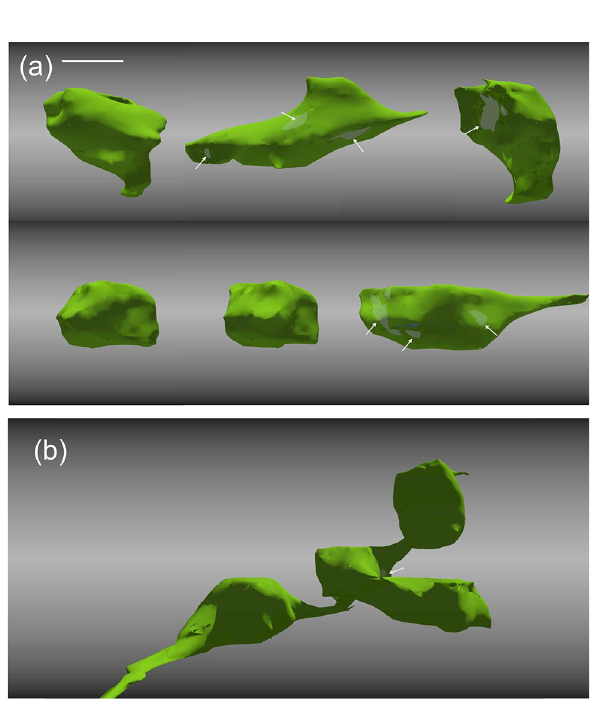
Figure 7. 3D-rendering of boutons either in isolation ( a ) or in continuation with each other ( b ). The active zone areas are visible only for some of the boutons (light green) from these perspectives (arrowed for clarity). The 3D-images were created using Blender 2.92 software (GNU General Public License, https:// www. blend erguru. com/). Scale bar ( a , b ): 1